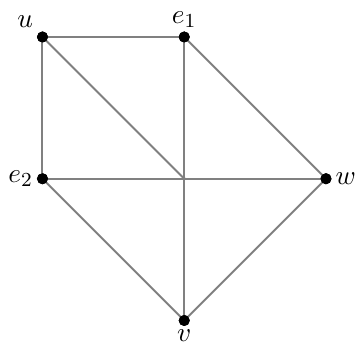
Figure 2 . The toric diagram of dP 2